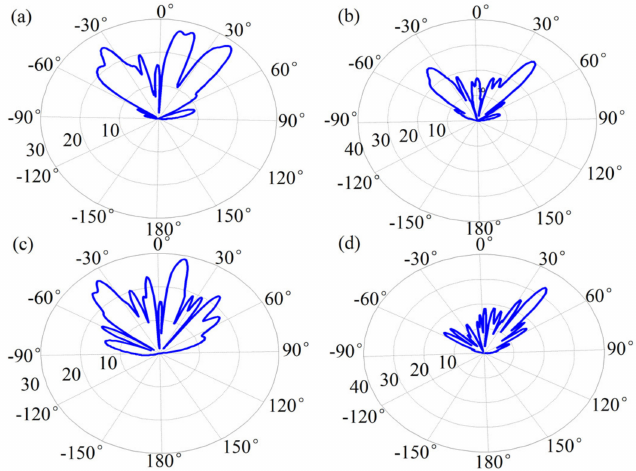
Figure 4. Far-field radiation map of reflected waves. ( a ) Far-field radiation map of three reflected beams. ( b ) Far-field radiation map of two symmetrical reflection beams. ( c ) Far-field radiation map of two asymmetric reflection beams. ( d ) Far-field radiation map of the single reflected beam. The unit is dB.